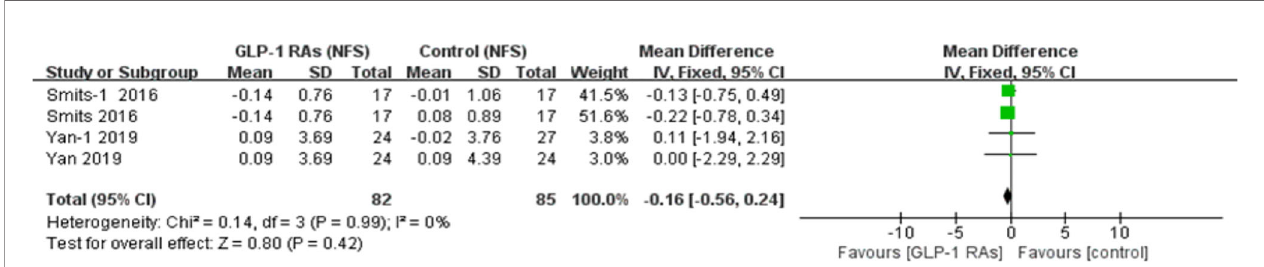
FIGURE 8 | Glucagon-like peptide-1 receptor agonists (GLP-1RAs); NAFLD fi brosis score (NHS); SD, standard deviation; CI, con fi dence interval; IV, inverse variance; Smits-l, concluded liraglutide vs placebo; Yan-1, concluded liraglutide vs